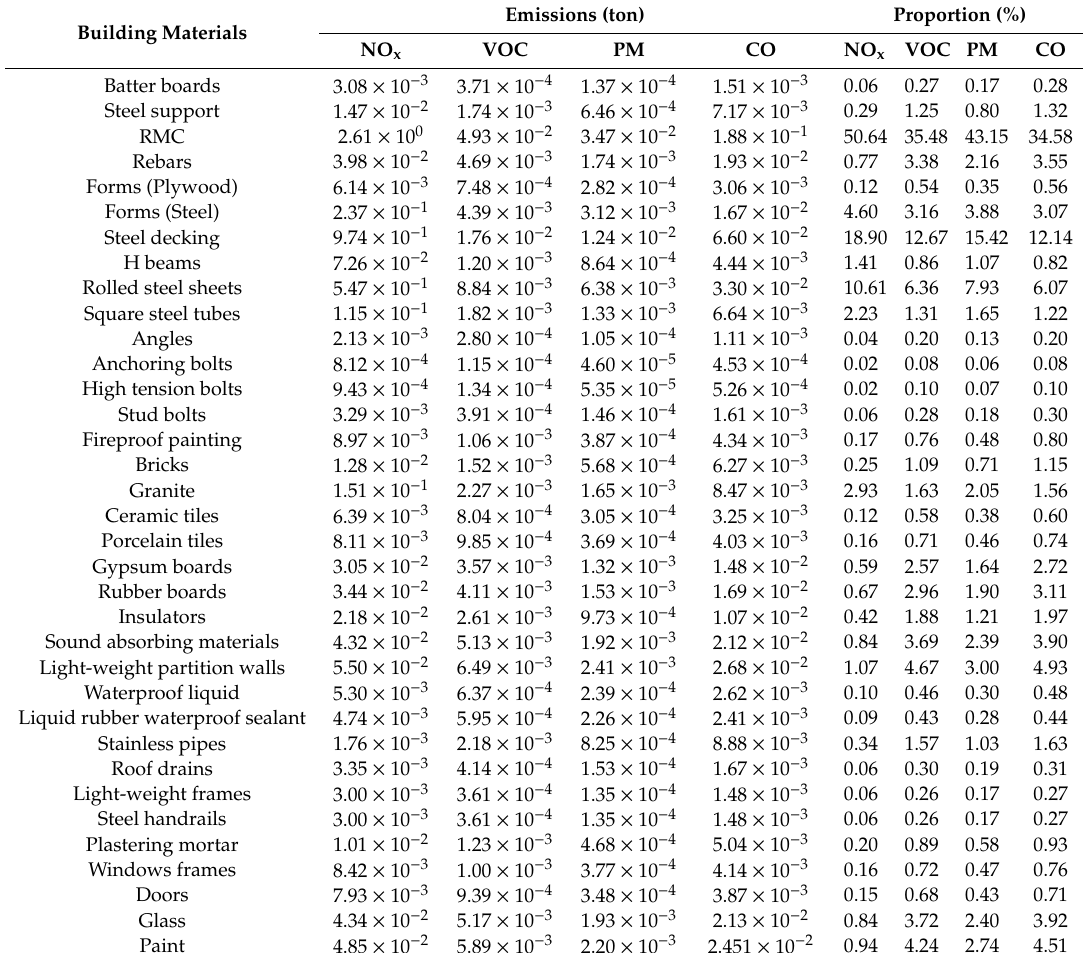
Table 5. Total pollutant emissions by building